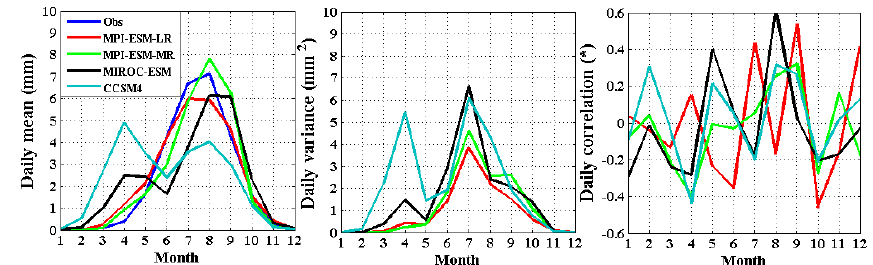
Figure 5. Comparison between the statistical properties of the observed daily precipitation data for the period 1961–1990 and the four GCM outputs.